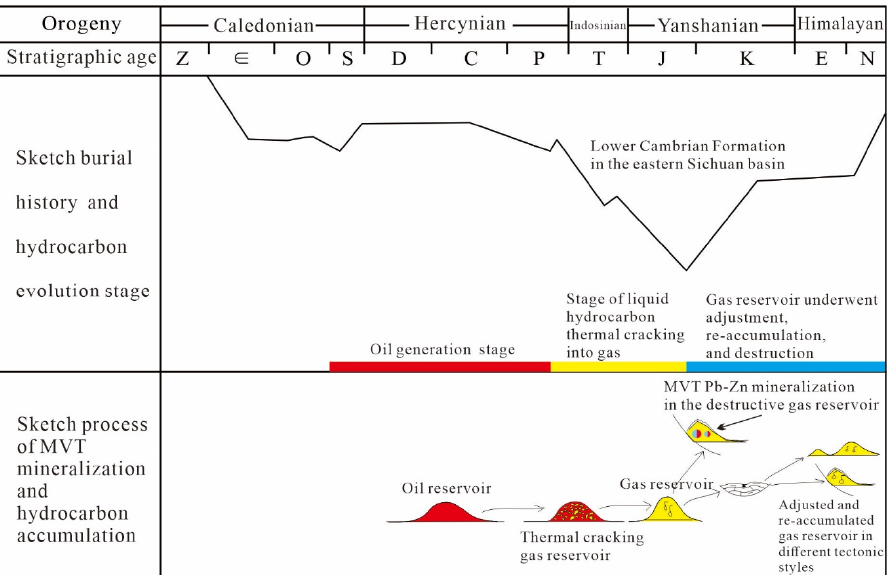
Figure 9. Sketch diagram of the ore-forming in the process of hydrocarbon accumulation and de- struction in the strong structural deformation area of the eastern Sichuan.